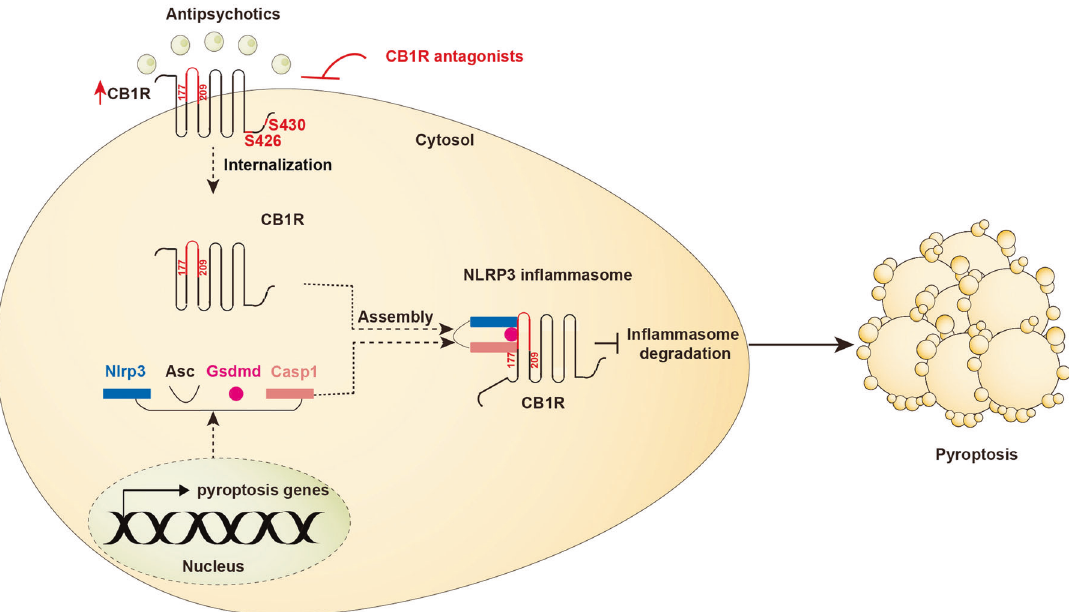
Fig. 8 Schematic illustration of CB1R-stabilized NLRP3 in fl ammasome to drive antipsychotics-induced cardiomyocyte pyroptosis. Upon chronic antipsychotics stimuli, CB1R internalized via S426 and S430 sites and physically interacted with the NLRP3 in fl ammasome through its region 177 – 209, and thereby preventing degradation of the NLRP3 in fl ammasome that consequently activated pyroptotic cell death and eventually contributed to antipsychotic drugs cardiotoxicity. CB1R inhibitors with low additional toxicity represent attractive